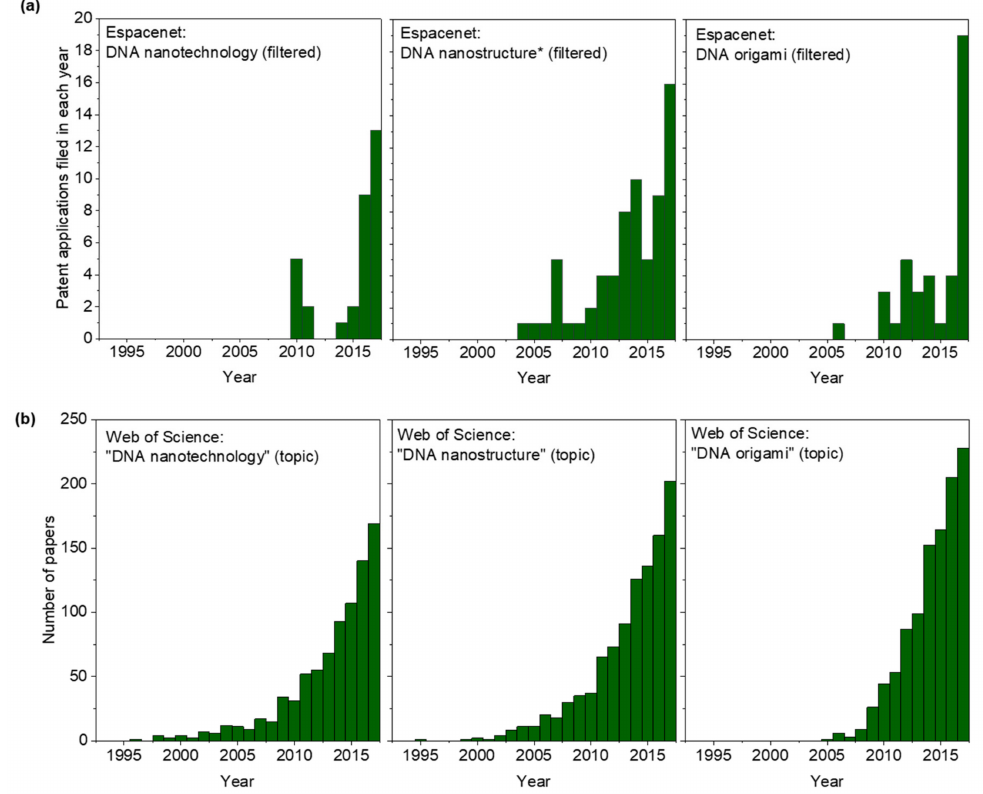
Figure 1. Patent applications and published papers in DNA nanotechnology. ( a ) Results from Espacenet searches for the indicated searches, after removal of duplicate and out-of-scope entries. ( b ) Web of Science results (unfiltered) for papers on indicated